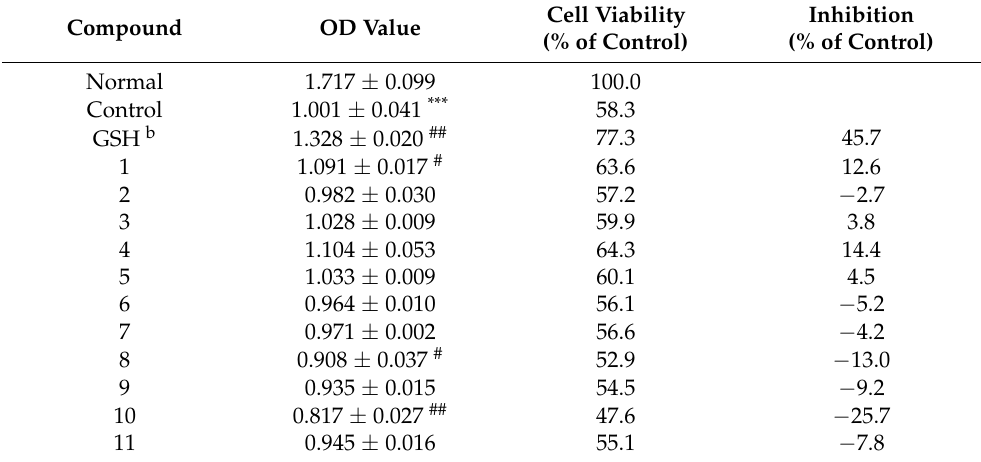
Table 2. Hepatoprotective effects of compounds 1 – 11 (10 µ m) against paracetamol-induced HepG2 cell a .